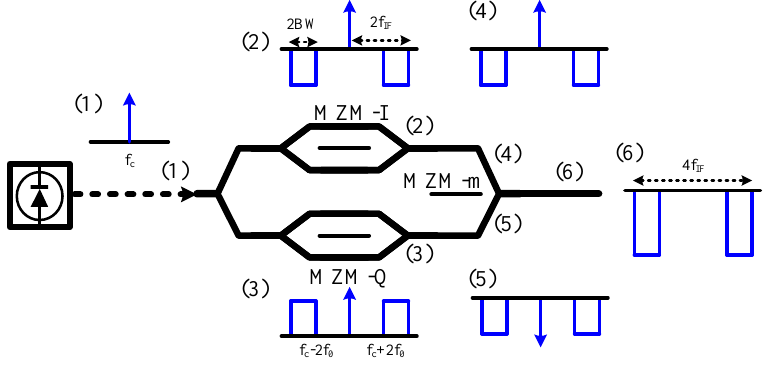
Figure 3. Principle of quadrupled signal generation through a DPMZM. BW: Bandwidth of IF